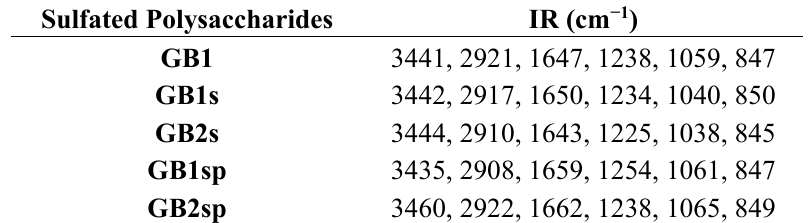
Table 2. IR spectrum data of sulfated polysaccharides from the red seaweed, G. birdiae . Sulfated